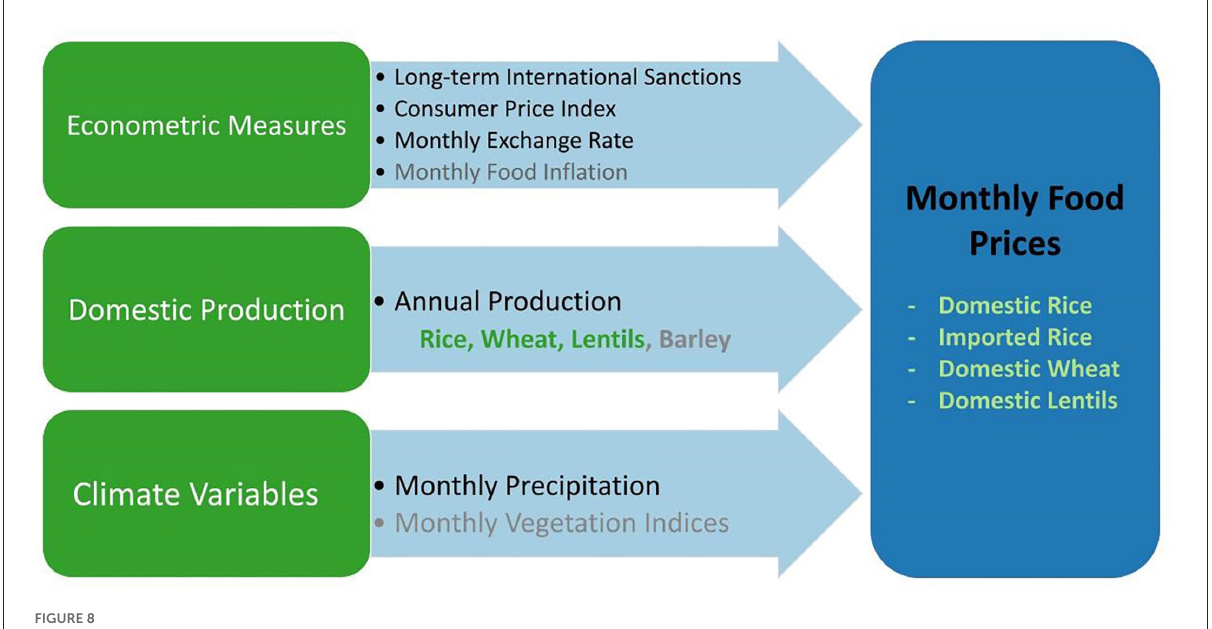
FIGURE8 Paper’s theoretical framework with all the variables included in the